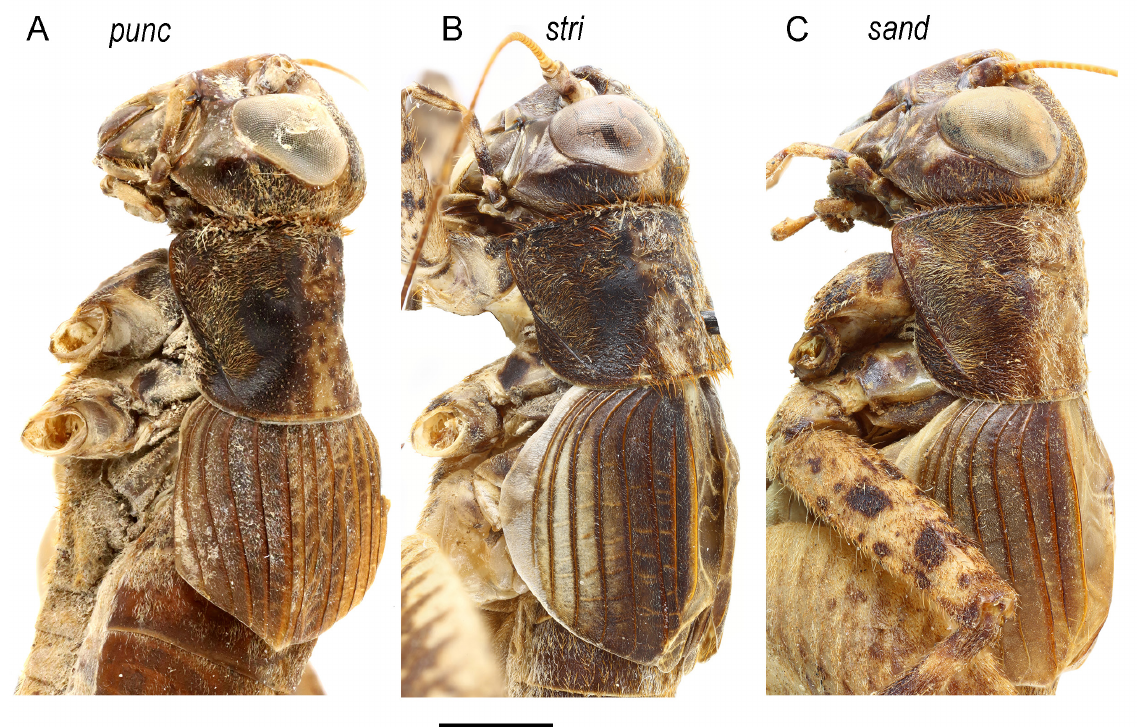
Fig. 6. Body in lateral view. A . Platybinthus punctatus (Brunner von Wattenwyl, 1898) gen. et comb. nov., syntype, ♀ (MNHN-EO-ENSIF1448). B . Platybinthus striolatus (Brunner von Wattenwyl, 1898) gen. et comb. nov., ♂ (ZIN). C . Platybinthus sandyi gen. et sp. nov., holotype, ♂ (MZB.ORTH.1786). Scale bar = 2